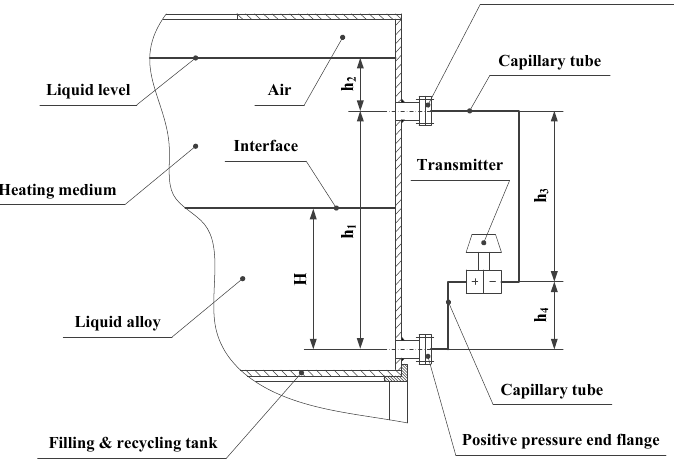
Figure 6. Di ff erential pressure level gauge with double Figure 6. Differential pressure level gauge with double flanges.